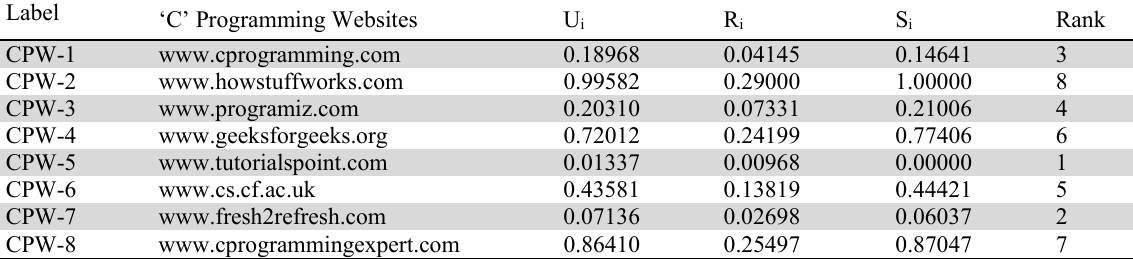
Rankings of E-learning websites obtained using VIKOR